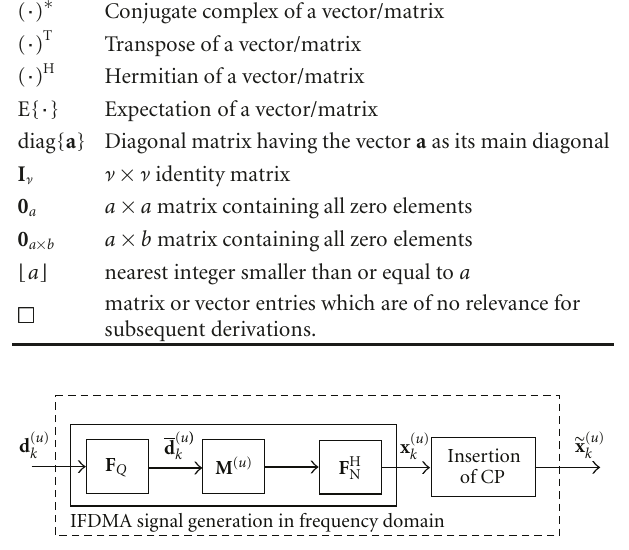
Figure 1: Block diagram of IFDMA signal generation in frequency domain and CP